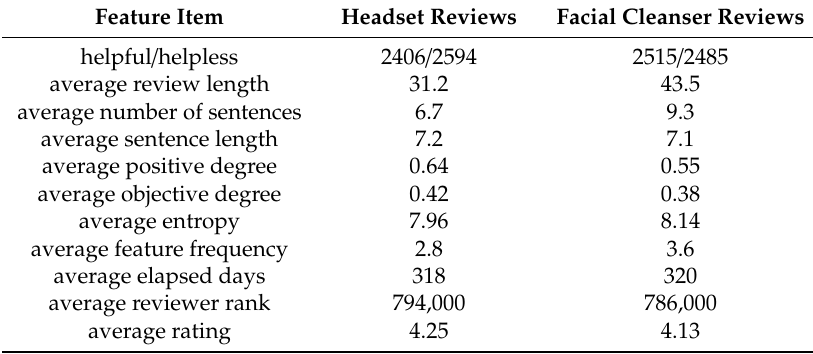
Table 3. Description of headset and facial cleanser datasets.